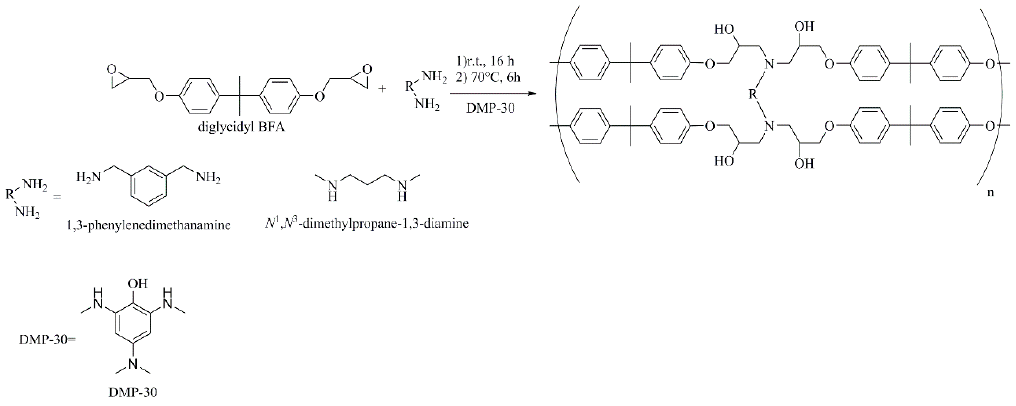
Figure 1. Polymerization process of epoxy resin with secondary amine based curing agent.